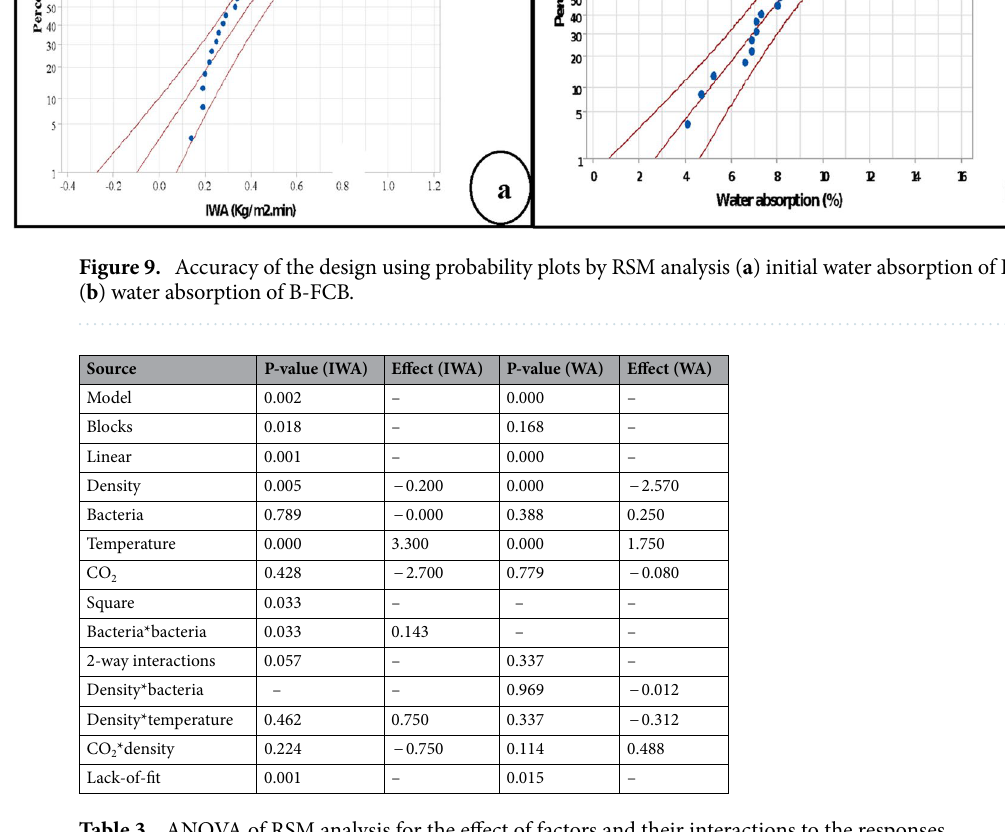
Table 3. ANOVA of RSM analysis for the effect of factors and their interactions to the